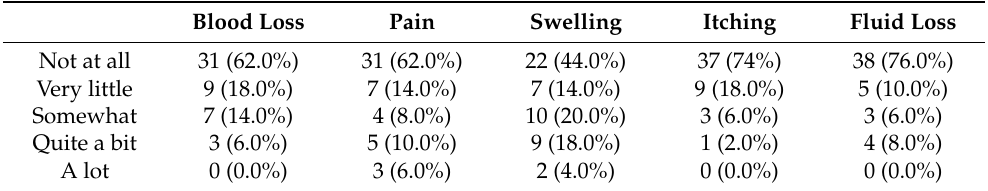
Table 3. Overview of responses on the PROM-HISS, n (%) (PROM-HISS = patient-reported haemorrhoidal-disease-haemorrhoidal impact and satisfaction score, n = number).